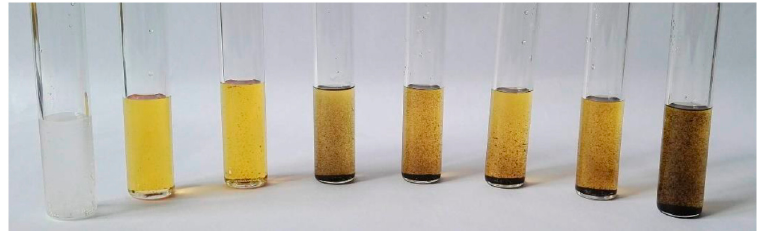
Figure 2. Samples of sulfolane, from the left: pure sulfolane, sulfolane after the experiment at 95 °C, sulfolane with water 2%, 3%, 4%, 5%, 6%, 6% with oxygen, and 6% with